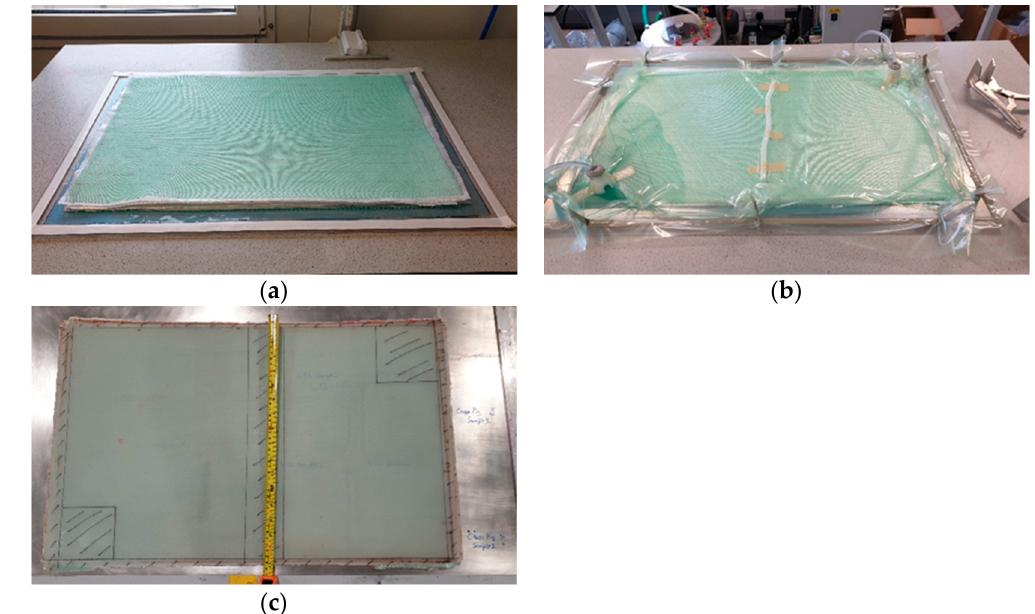
Figure 4. ( a ) Substrate fiber layup on mold; ( b ) substrate fiber layup under vacuum with resin injection; ( c ) completed substrate with unusable sections marked for removal.